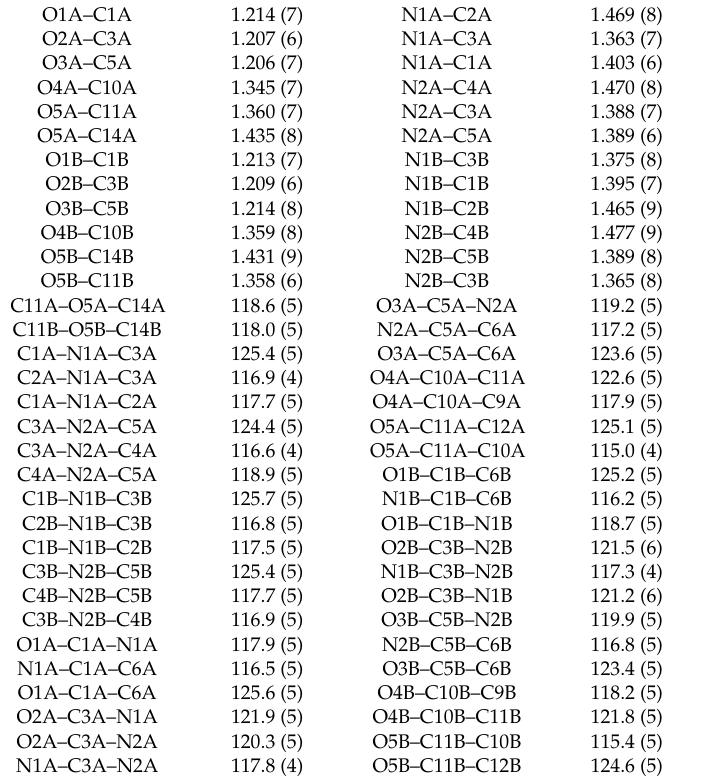
Table 2. Selected geometric parameters (Å, ◦ ) of 1 .